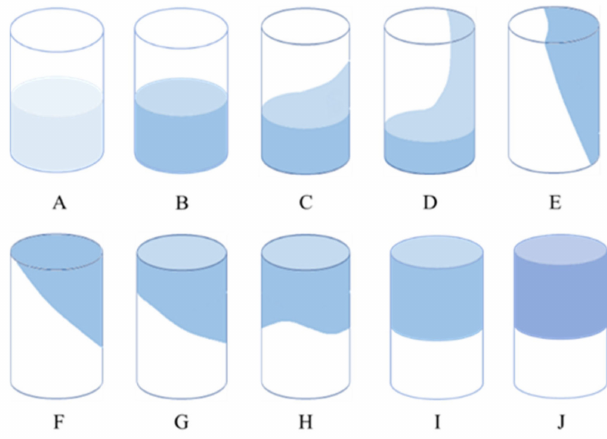
Figure 1. Schematic diagram of GSC strength code. Table 1. GSC classification